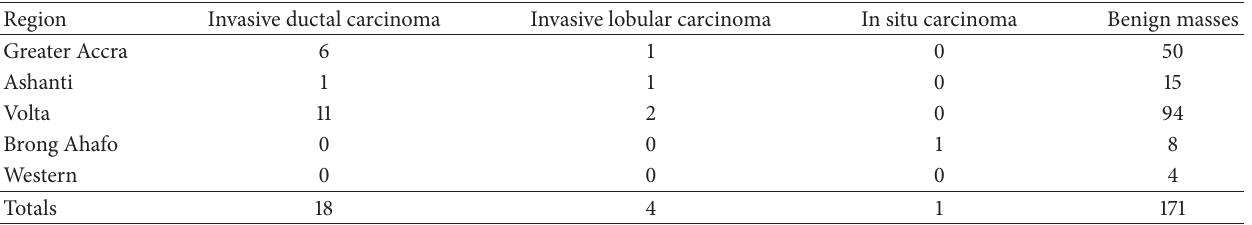
Table 2: Histological classification of breast cancer in the selected regions in Ghana. Volta Region unexpectedly had the highest burden. Region